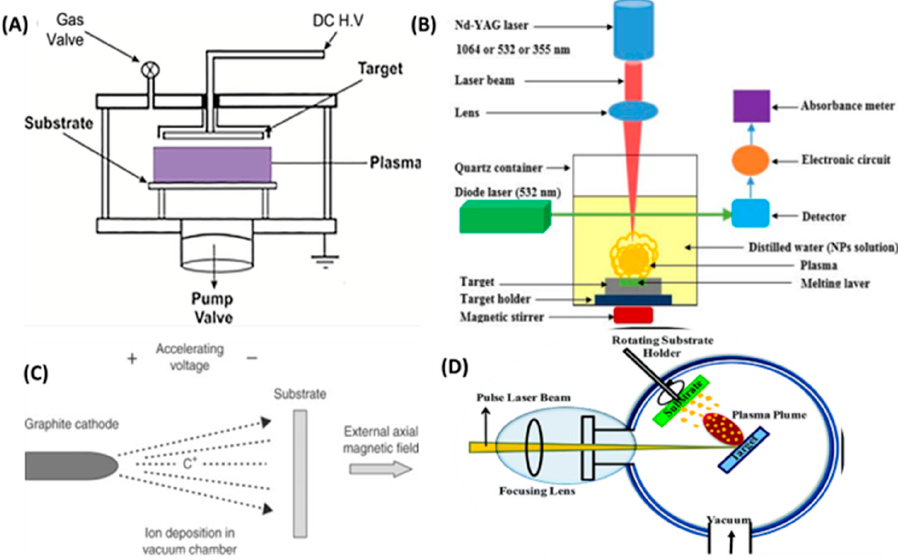
Figure 12. ( A ) Schematic illustration of DC–magnetron sputtering system. ( B ) Experimental setup of laser ablation technique. ( C ) Ion Beam Deposition technique. ( D ) electron beam evaporation. Adapted from [59] with permission.